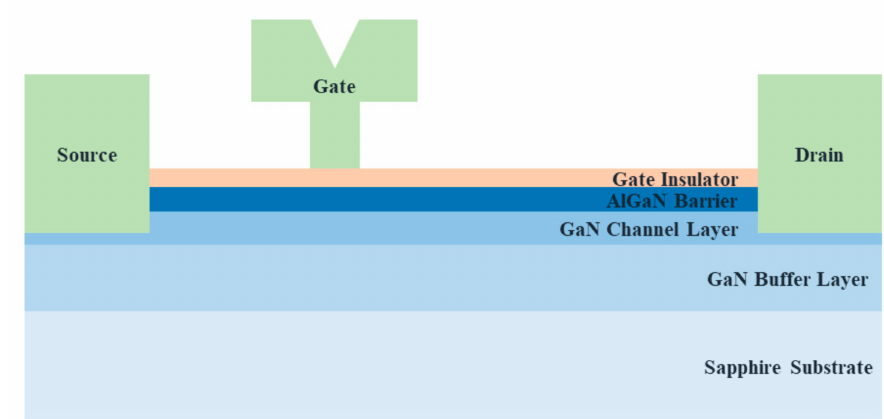
Figure 1. Schematic cross-section of the processed GaN-based metal-insulator-semiconductor high electron mobility transistors (MIS-HEMTs). A 5 nm-thick SiN and HfO 2 layer were employed for Sample-SiN and-HfO 2 , respectively, as a gate dielectric